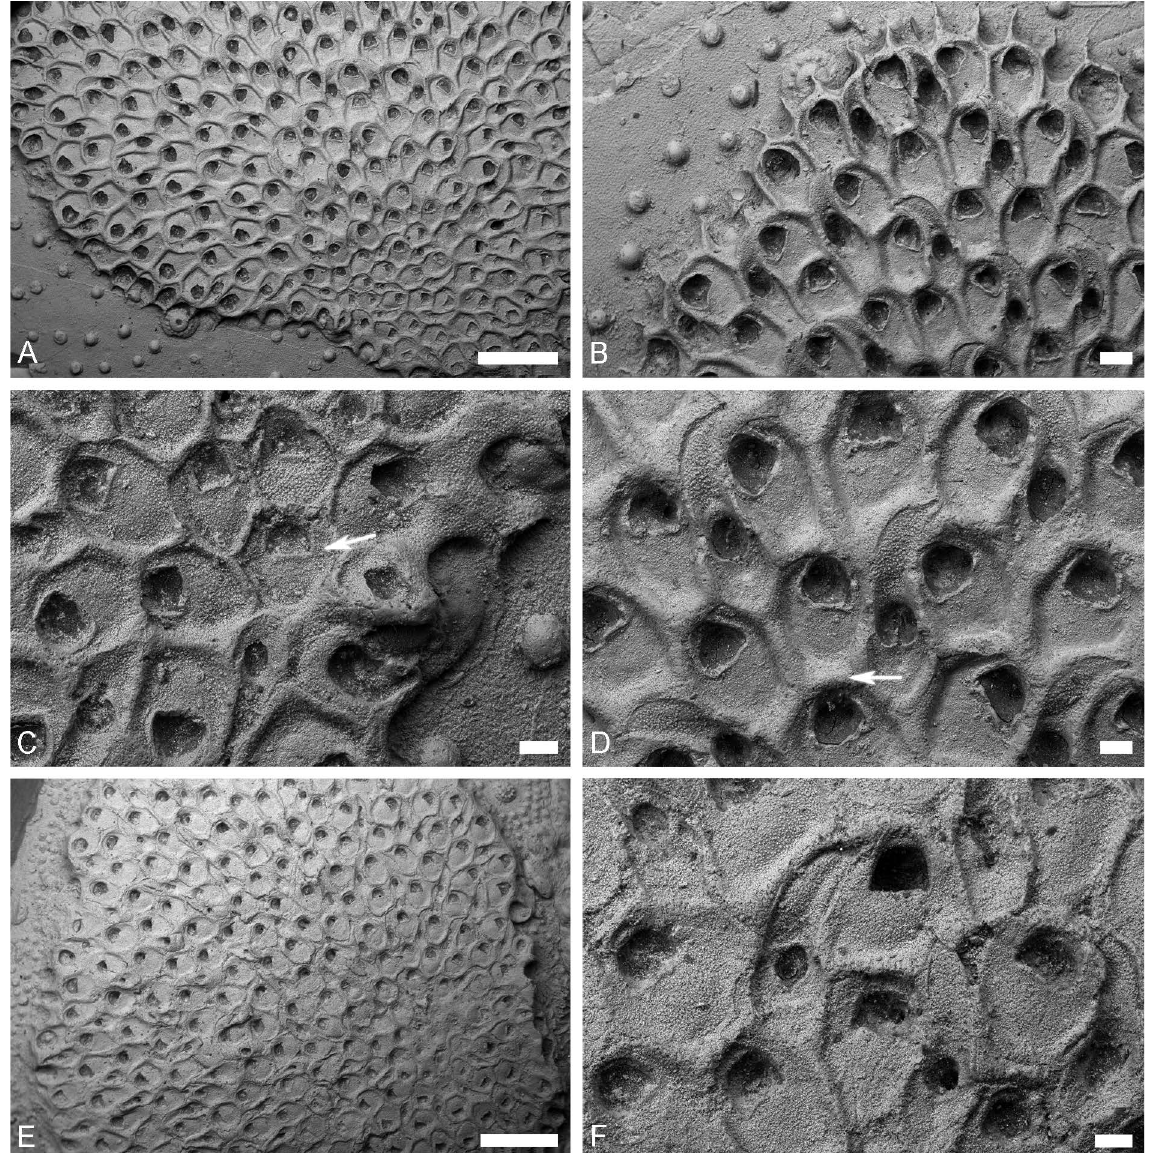
Fig. 6. Rhagasostoma minuens Brydone, 1936. A–D . Lectotype, SM B36883, late Santonian ( Uintacrinus socialis Zone/lower Marsupites testudinarius Zone), between Brighton and Roedean, East Sussex, England, UK. A . Overview of encrusting colony. B . Growing edge. C . Early astogeny, ancestrula (arrowed), autozooids and avicularia. D . Autozoods with endozooidal ovicells (arrows)